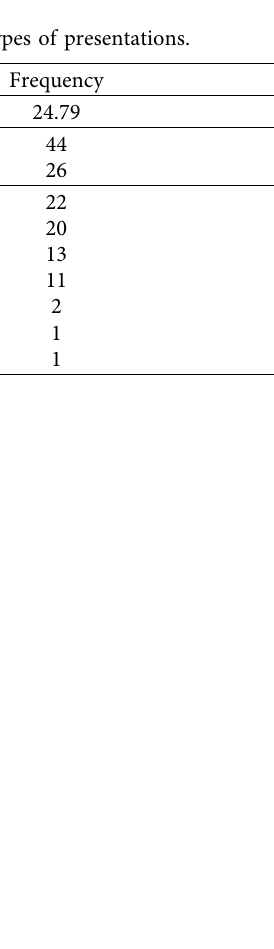
Figure 1: CT scan of the abdomen showing intestinal obstruction caused by Meckel’s diverticulum. Table 2: Showing the dimensions of the Meckel’s diverticulum.